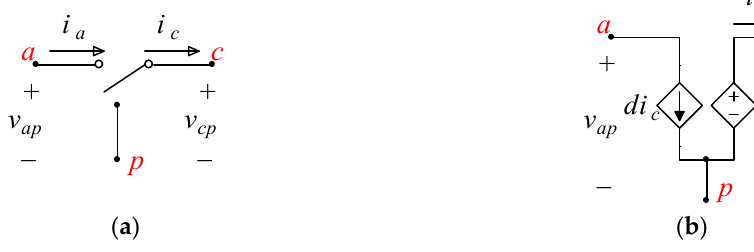
Figure 1. Three-terminal pulse width modulation (PWM) switch model: ( a ) three-terminal switching network; ( b ) large-signal averaged circuit model.